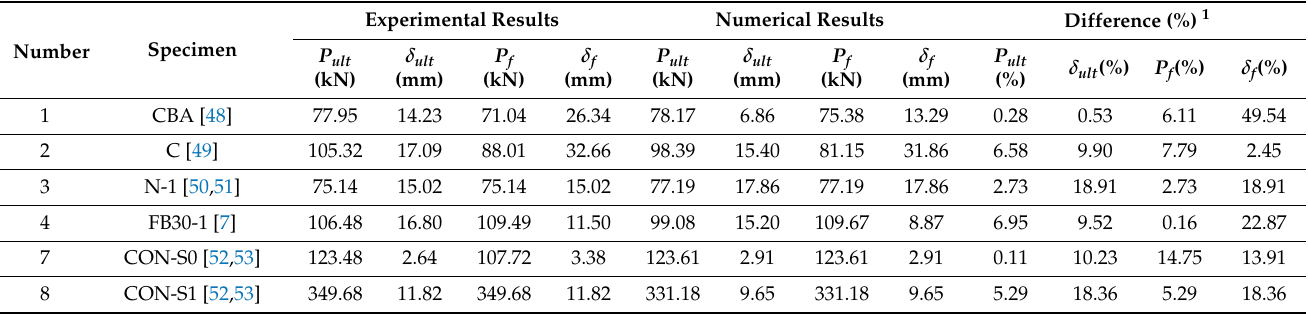
Table 5. Comparison between Numerical and Experimental Results of Control